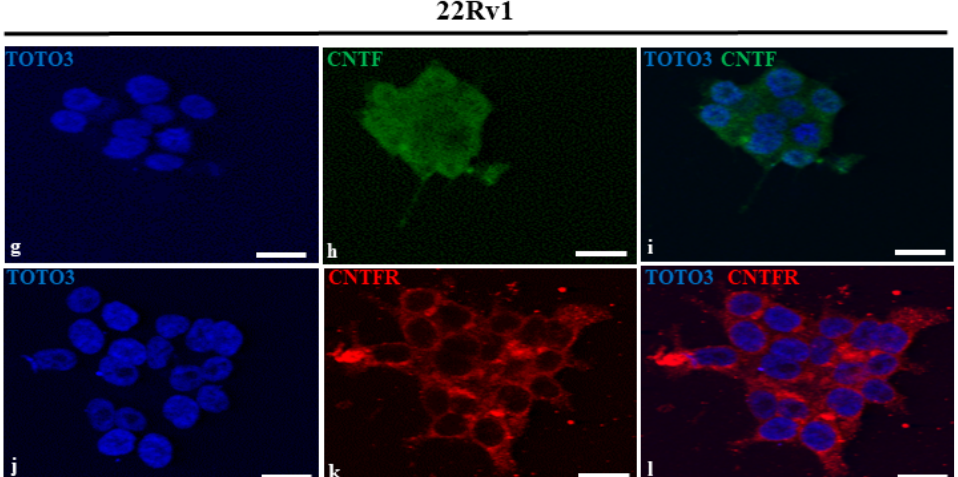
Figure 2. Immunofluorescence of CNTF and CNTFR α in LNCaP e 22Rv1cell lines. Nuclei ( a , d , g , j ) are stained in blue. CNTF ( b , h ) was stained in green and was mainly expressed in cytoplasm of both LNCaP and 22Rv1 cell lines. CNTFR α ( e , k ) was stained in red and was expressed in the cytoplasm and cell membranes with a high intensity in the perinuclear region of both cell lines. ( c , f , i , l ) represent merged channels. Scale bars: 30 μ m.